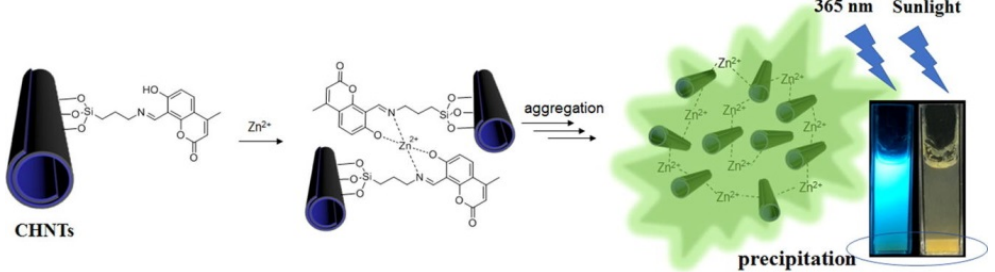
Figure 11. Synthesis of coumarin modified HNTs and their application as Zn 2+ sensors. Reproduced with permission from [126].